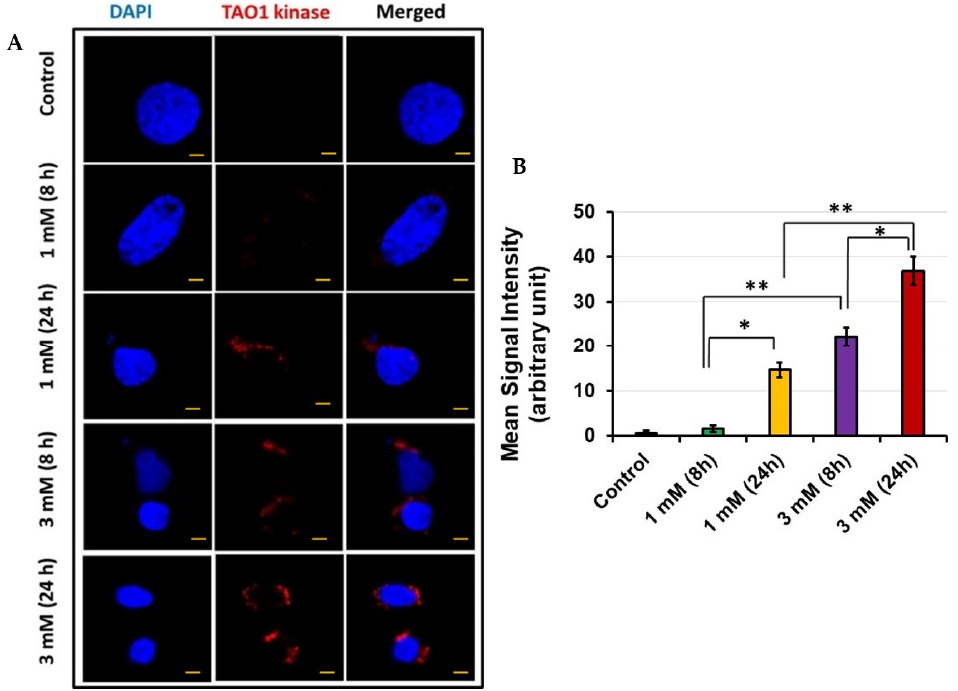
Figure 4. TAO1 kinase immunostaining: ( A ) representative photomicrographs showing Sap30bp expression in HEI-OC1 cells treated with gentamicin. Red: TAO1 kinase; Blue: cell nuclei. Scale Bars: 20 µM; ( B ) ImageJ software was used to determine mean signal intensity for TAO1 kinase immunostaining. * p < 0.05 or ** p < 0.01.